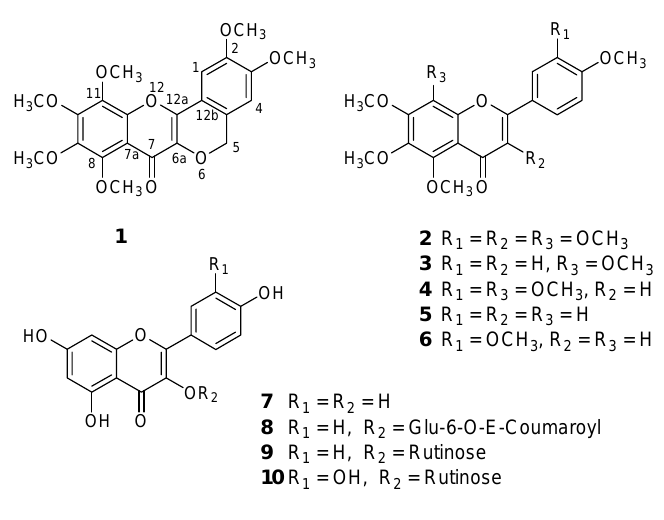
Figure 1. Structures of compounds 1 - 10